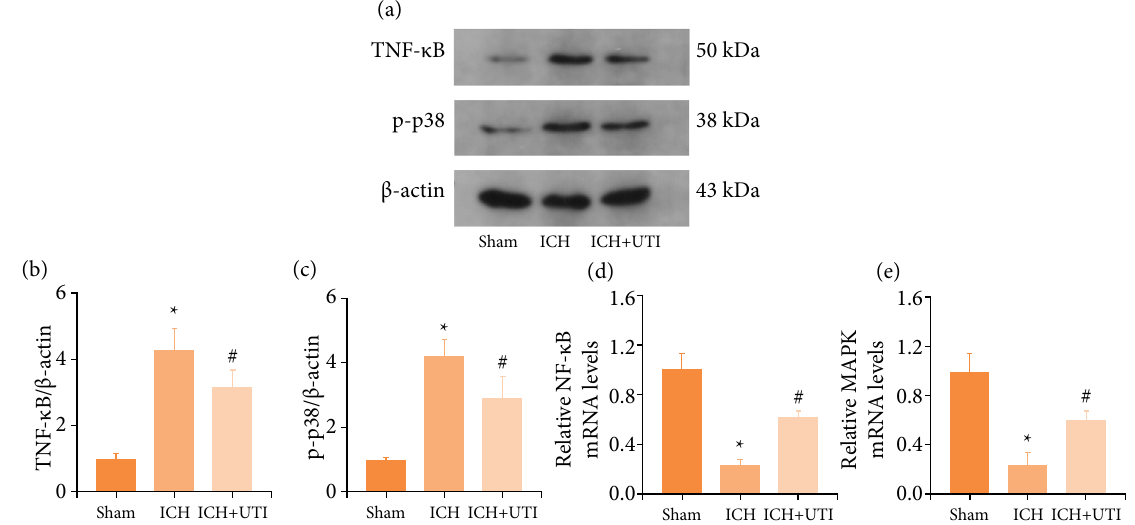
Figure 5 - UTI regulates necroptosis and neuroinflammation by modulating the MAPK/ NF- κ B signaling pathway after ICH. (a) Levels of MAPK, and NF- κ B in the brain cortex of mice after ICH were determined using Western blotting; (b) Quantification of NF- κ B levels in the brain cortex relative to β -actin, the loading control; (c) Quantification of MAPK levels in the brain cortex relative to β -actin; (d) Levels of NF- κ B mRNA in the brain of ICH mice were measured by real-time PCR; (e) Levels of MAPK mRNA in the brain of ICH mice were measured by real-time PCR (n = 5, Data are presented as the mean ± SD, * p < 0.05 vs. Sham; # p < 0.05 vs.